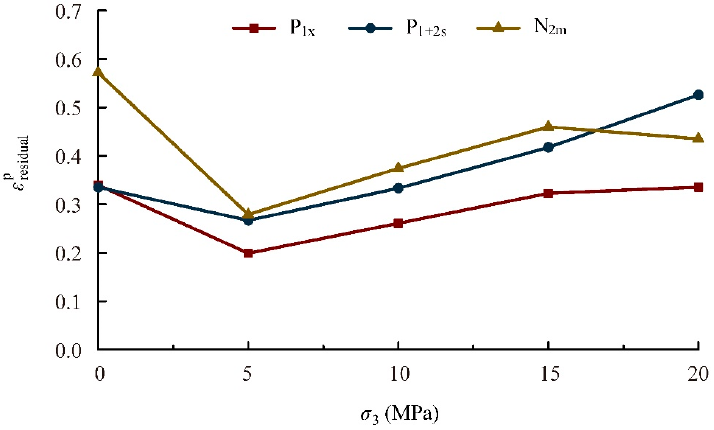
Figure 12. Schematic diagram of the relationship between the residual critical plastic strain and confining pressure.